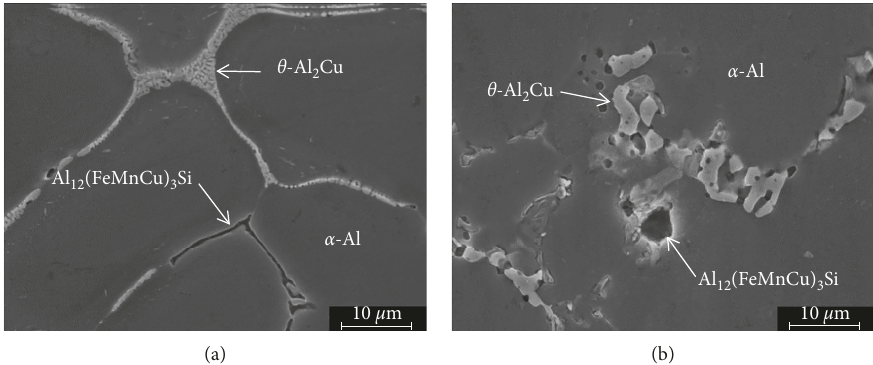
Figure 3: SEM micrographs of 2017A alloy under 90MPa squeeze pressure: (a) as-cast state; (b) after T6 heat treatment.